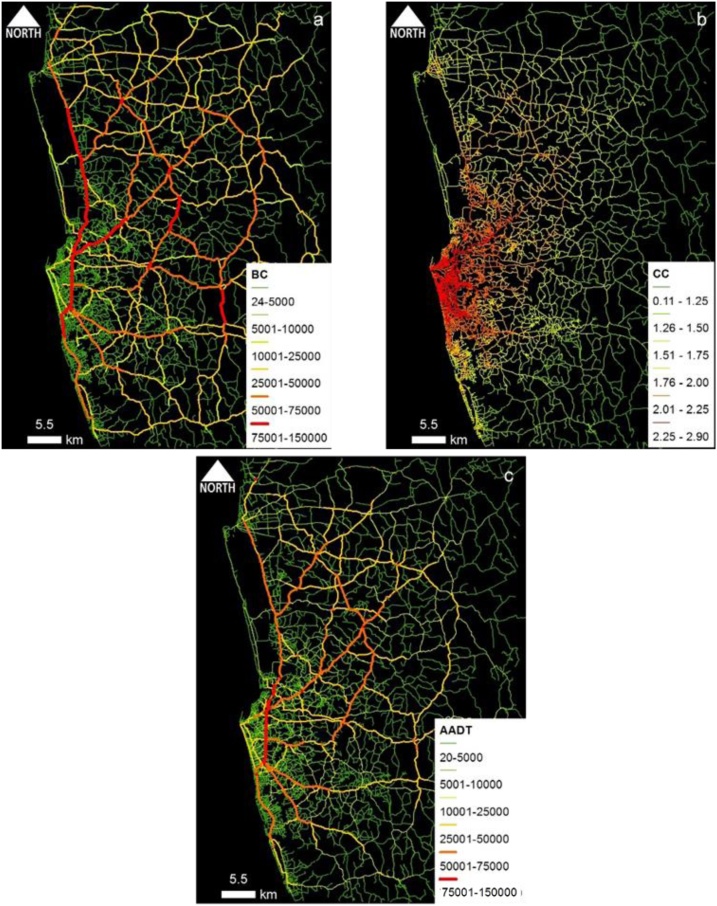
Colombo case study area: Spatial distribution of (a) BC(PD) and (b) CC(PD) and (c) estimated AADT.